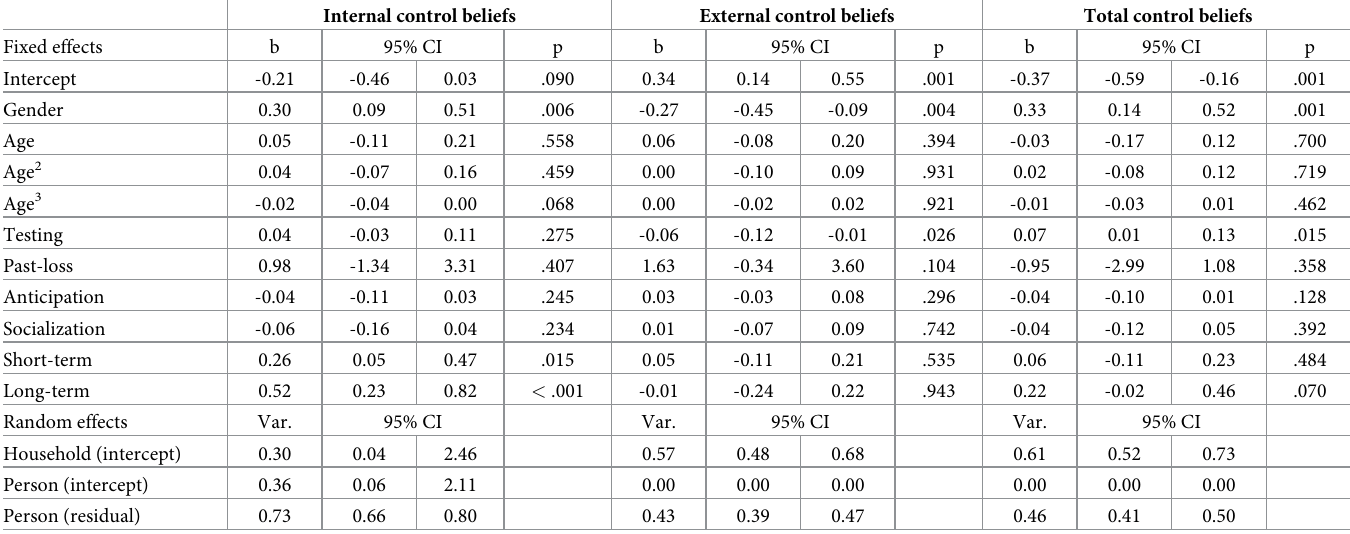
Table 9. Changes in perceived control before and after the death of a partner in individuals who experienced this loss between 1991 and 1999 ( N = 437).